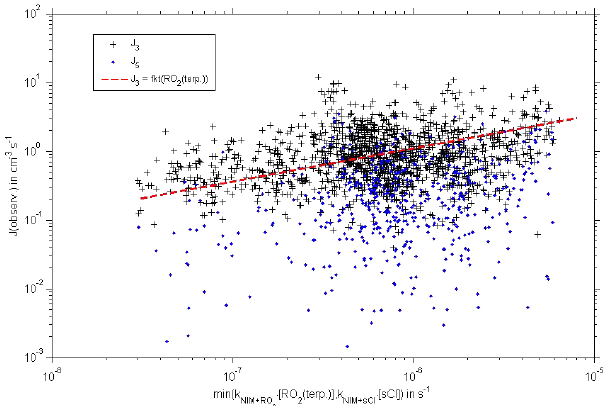
Figure 16. Scatter plot of the activation term in Eq. (5) vs. the for- mation rates at 3 and